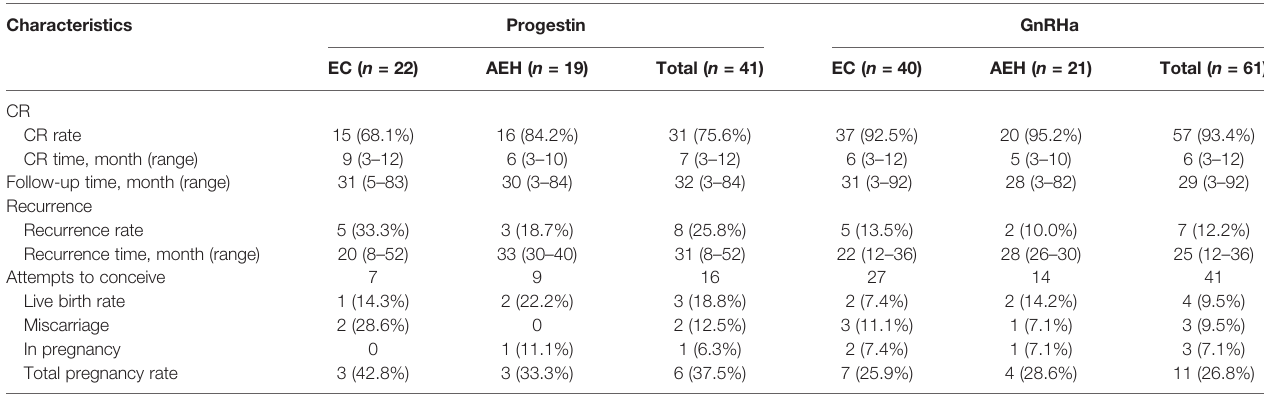
TABLE 3 | Outcome of progestin and GnRHa treatment.